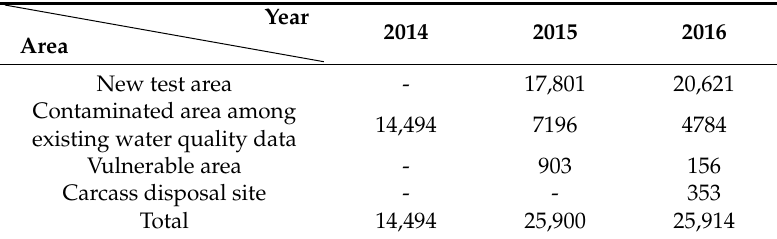
Table 2. Number of samples for water quality